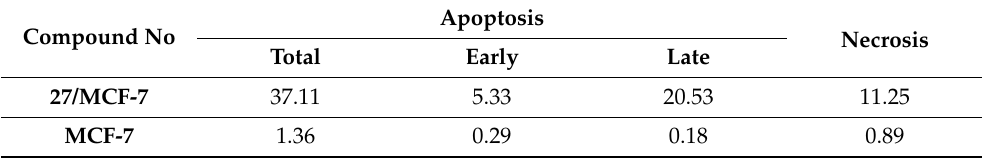
Figure 3. Determination of cell cycle arrest by flow cytometry. Effect of compound 27 on the cell cycle distribution of the MCF-7 cell line.